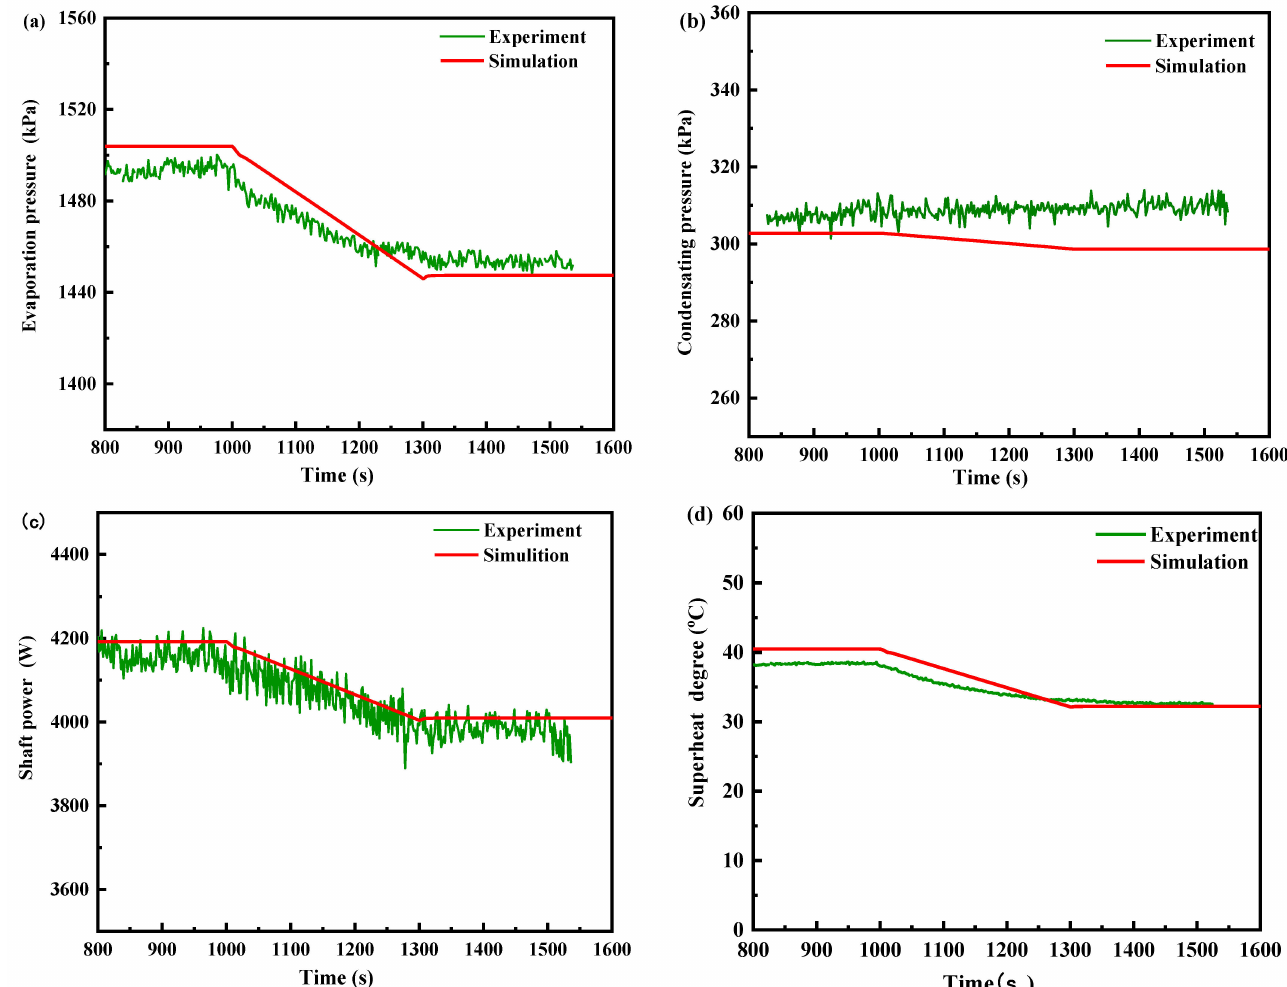
Figure 5. Comparison between the simulation and experimental results of ORC: ( a ) evaporation pressure, ( b ) condensation pressure, ( c ) power and ( d ) superheat